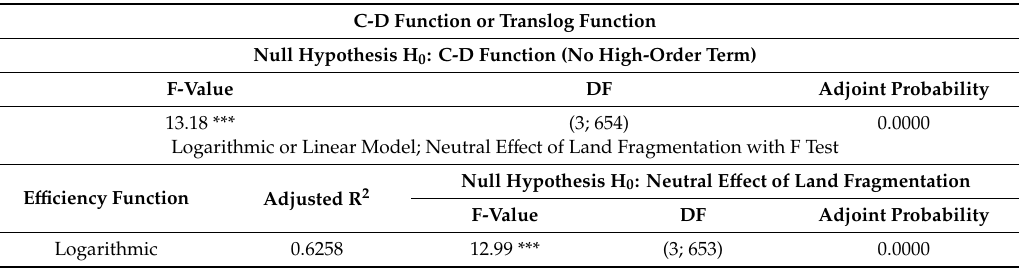
Table 2. Results of model